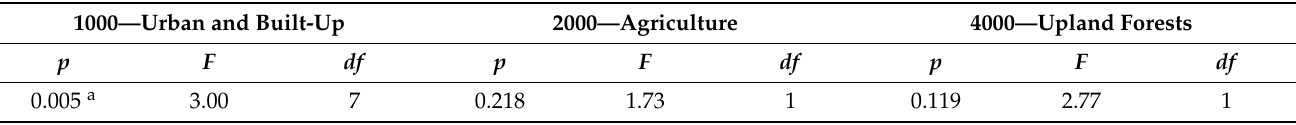
Table 4. AOV results to test for differences in plot AGTC (kg) between sub-classes for Level I “Urban and Built-up”, “Agriculture”, and “Upland Forest” classes ( p : p -value; F : F -value; df : degrees of freedom).